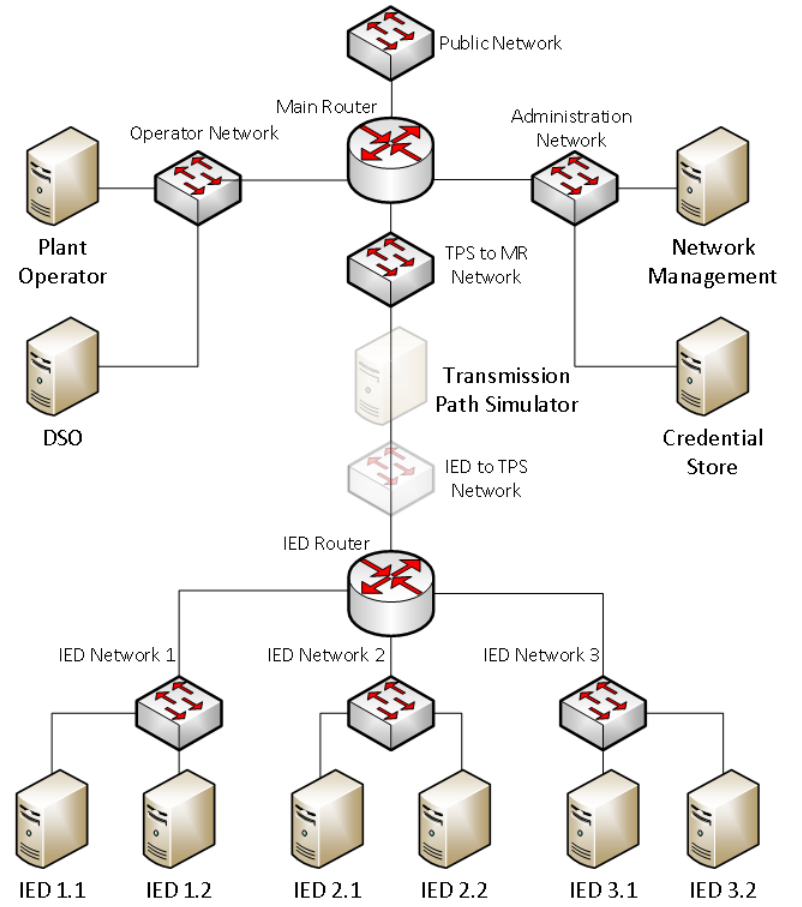
Figure 9. Realised testbed for validation and